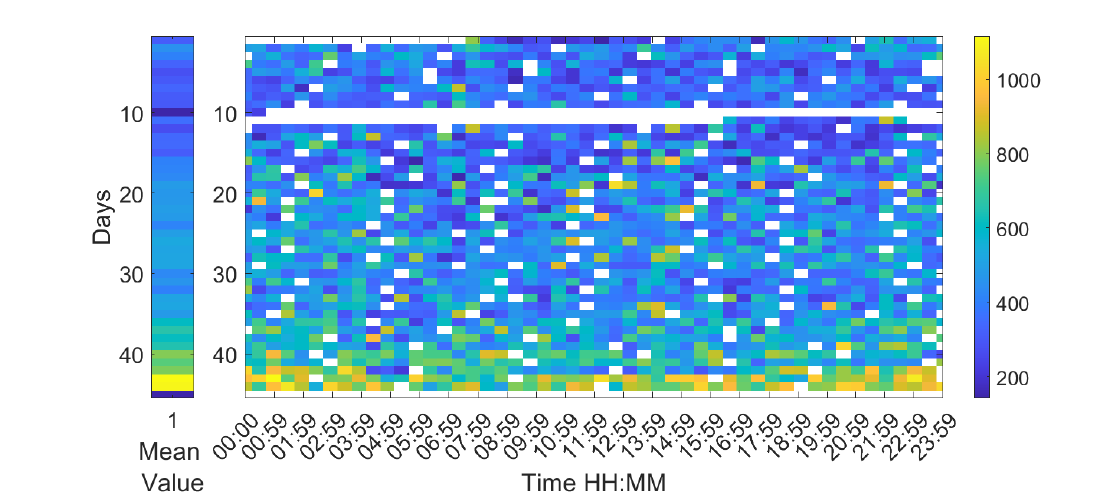
Figure 8. Map of the variance in frequency at 30 min intervals during the 44 days of a complete production cycle. The horizontal axis shows the hours of the day and night, and the vertical axis shows the days of the